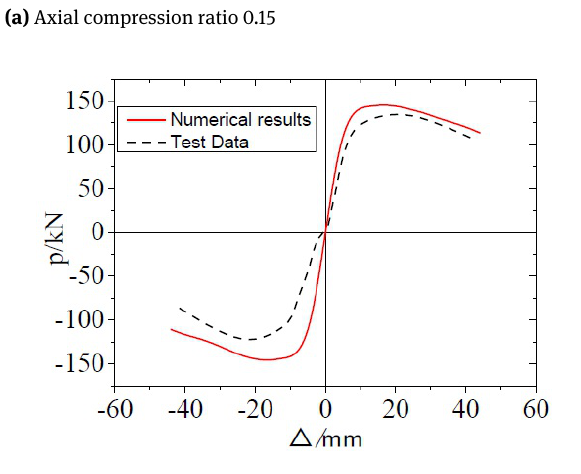
Figure 5: Concrete column skeleton curve comparison chart